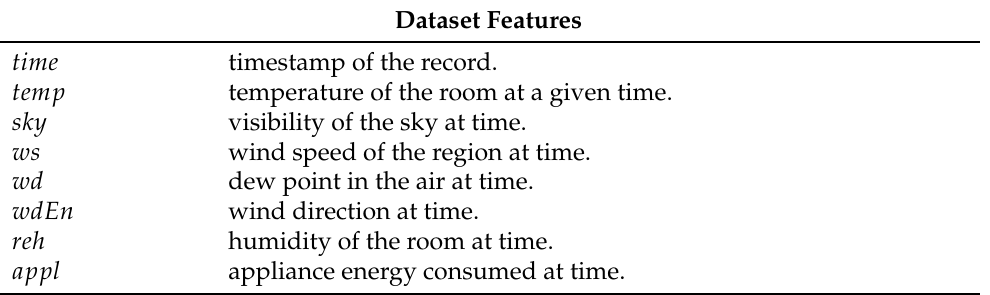
Dataset Features